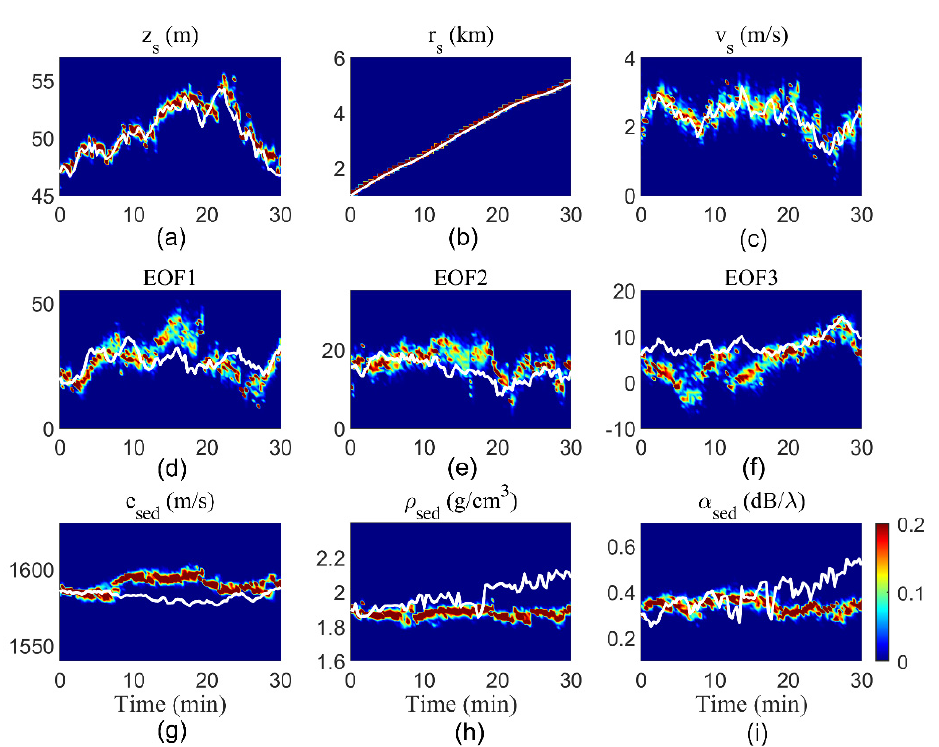
Figure 7. ASIAEX improved PF tracking results of nine parameters: time-evolving 1-D marginal PPDs for ( a ) depth, ( b ) range, and ( c ) speed of the source; ( d-f ) three EOFs; and the sediment ( g ) sound speed, ( h ) density, and ( i ) attenuation. The solid line represents the true trajectory.